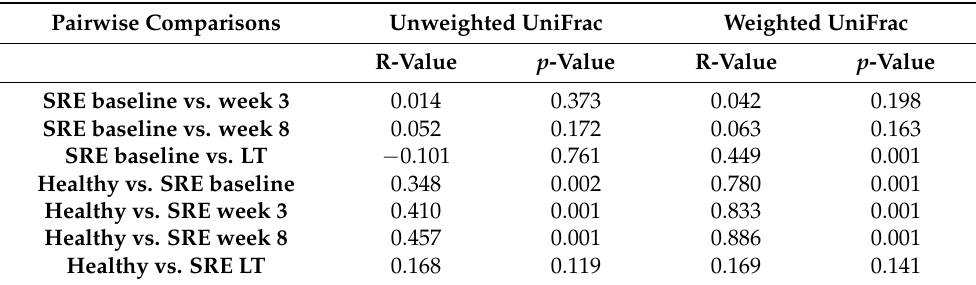
Table 2. Analysis of similarities (ANOSIM) of beta diversity, performed on qualitative (Unweighted UniFrac) and quantitative (Weighted UniFrac) microbiome composition data. R-values indicate the similarity between groups, with values close to 0 indicating similar microbiome composition, and values close to 1 indicating highly different microbiome composition. LT = long-term follow-up.